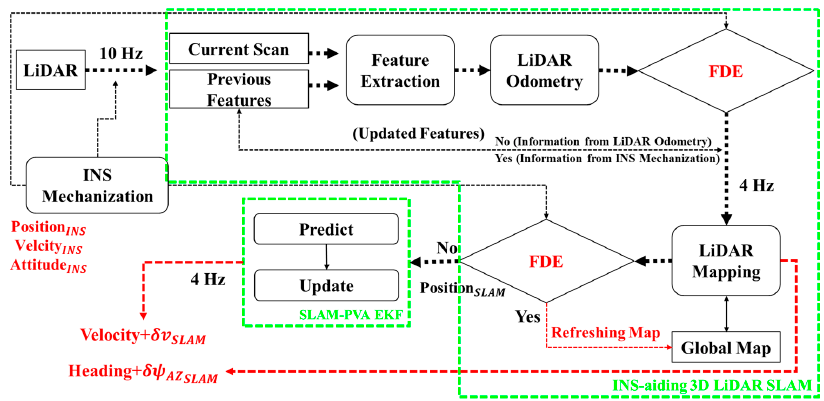
Figure 6. Structure of the proposed INS-aiding 3D LiDAR-SLAM and SLAM-position velocity acceleration (PVA) extended Kalman filter (EKF).